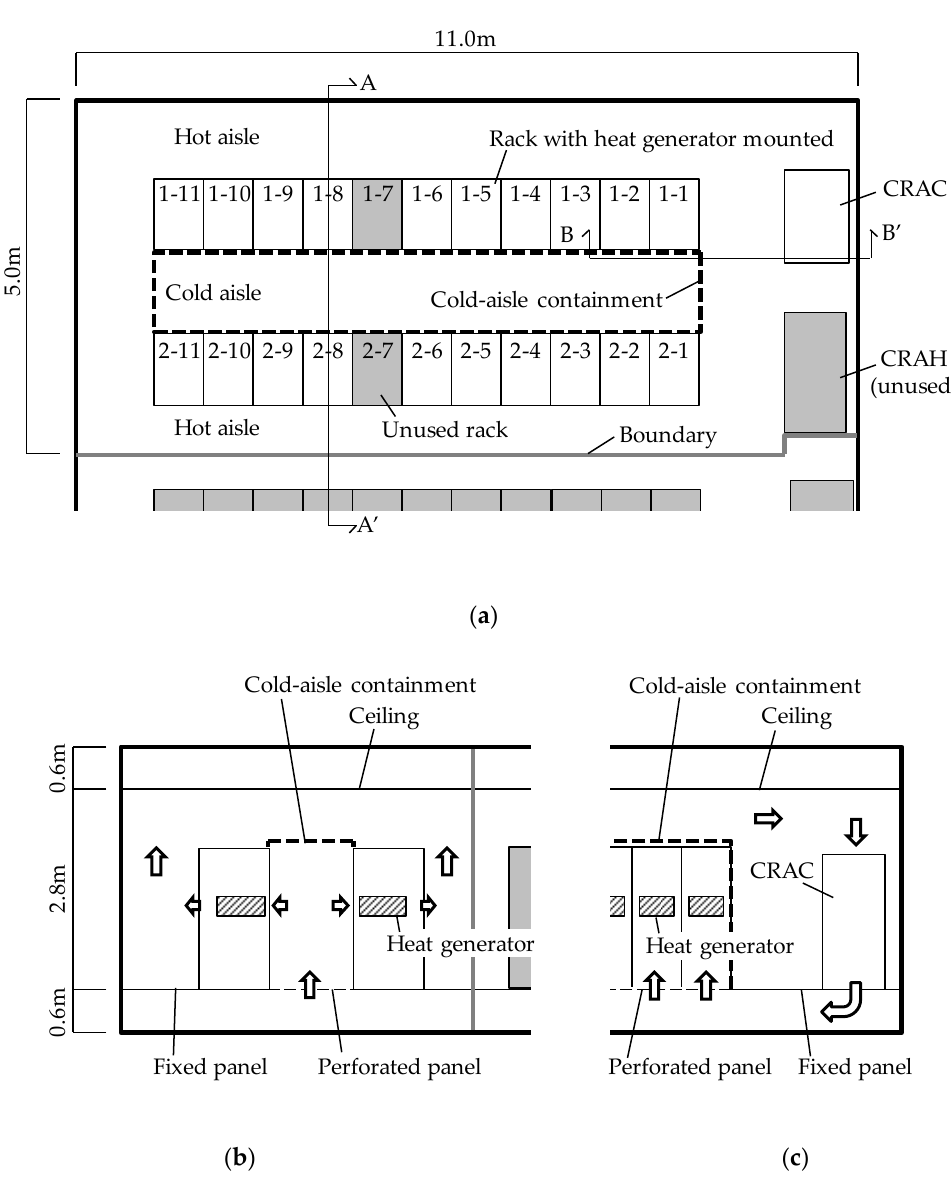
Figure 1. ( a ) Plan view of verification room, ( b ) cross section A-A’, and ( c ) cross section B-B’. Table 3. Measurement